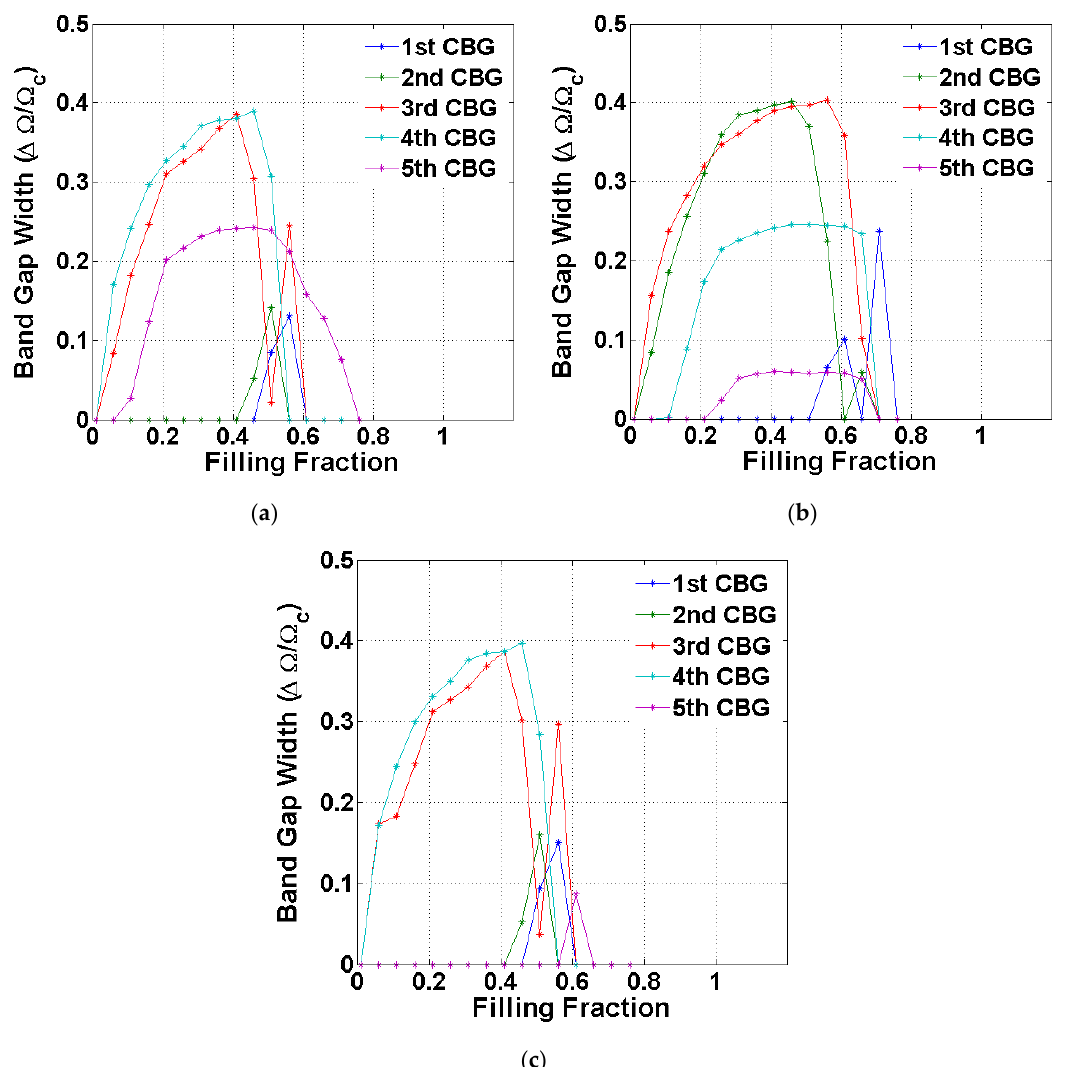
Figure 5. Complete band gap widths of the MPnC with circular scatterers and Kagomé lattice, considering Z modes with piezoelectricity ( a ), Z modes with piezomagnetism ( b ), and Z modes with piezoelectricity and piezomagnetism ( c ).